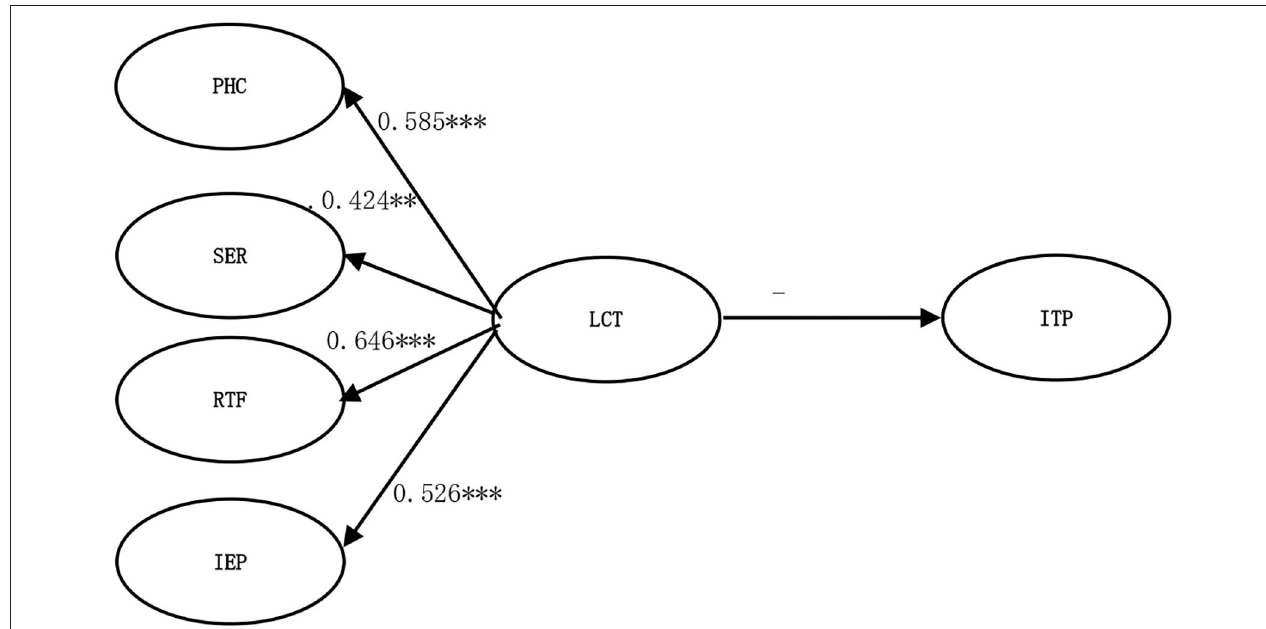
FIGURE 2 | Predictive validity analysis. PHC, Personal health concerns; SER, Shock on economic revenue; RTF, Reduced travel freedom; IEP, Inconvenience from epidemic prevention; LCT, Leisure constraints; ITP, Intention to participate. Significant at ** p < 0.01, *** p < 0.001.